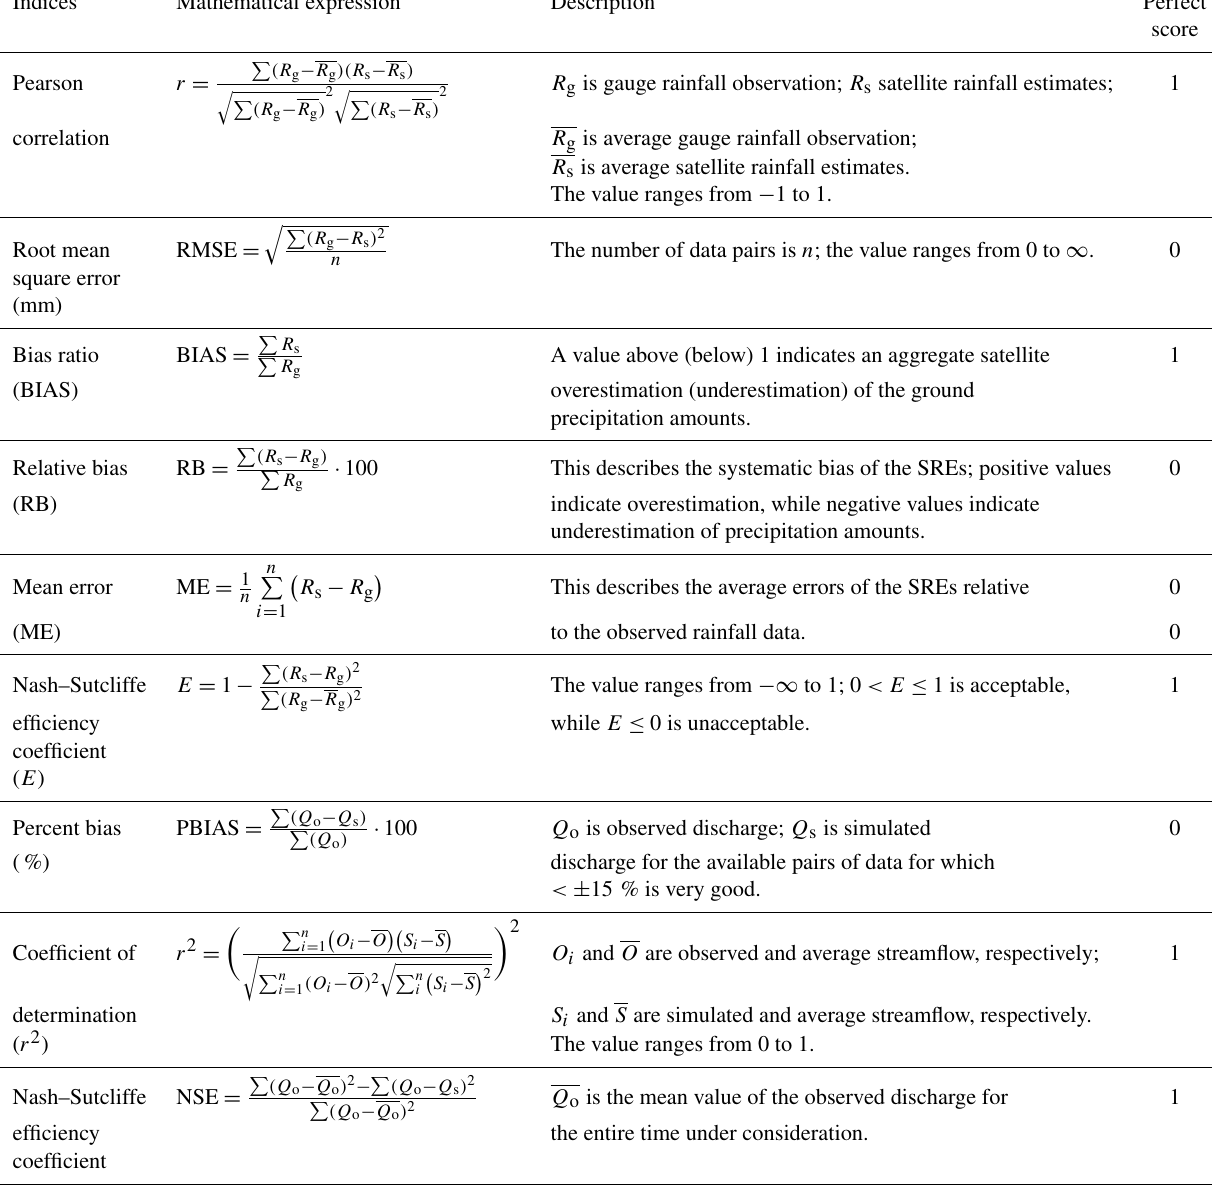
Table 2. SRE evaluation indices, mathematical descriptions and perfect score. Indices Mathematical expression Description Perfect